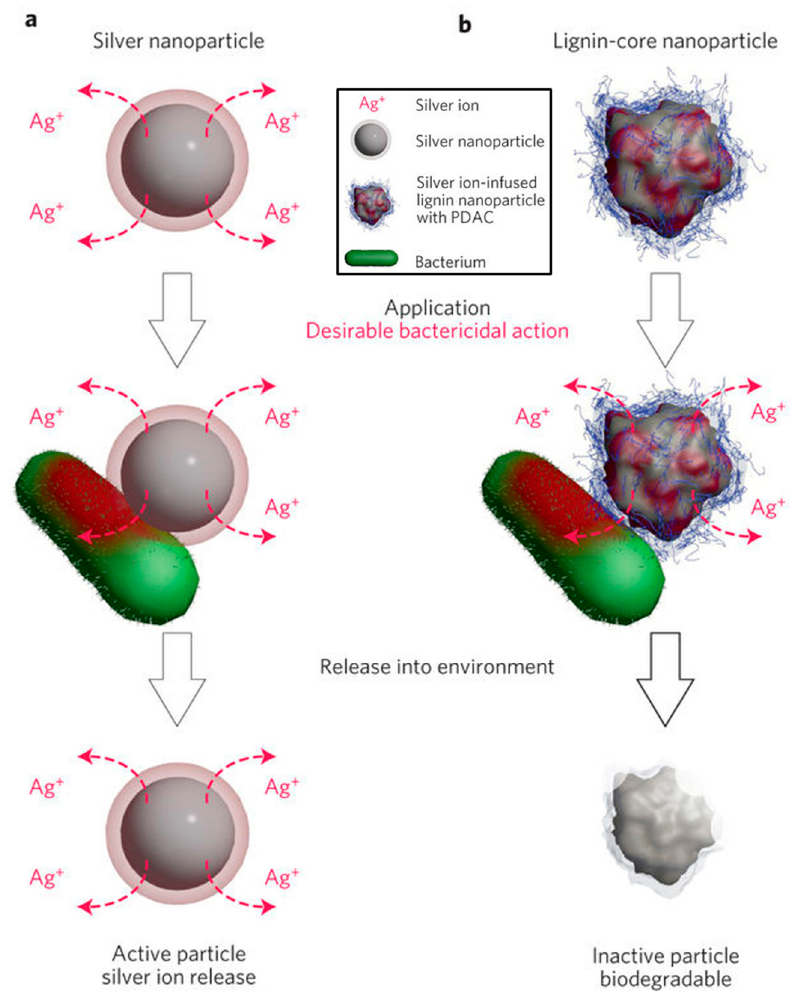
Figure 4. Proposed use cycle and principle of the bactericidal action of environmentally benign lignin- core nanoparticles ( b ) and the currently used silver nanoparticles ( a ). Reprinted by permission from Macmillan Publishers Ltd.: Nature Nanotechnology [66], Copyright 2015. from Macmillan Publishers Ltd.: Nature Nanotechnology [66], Copyright